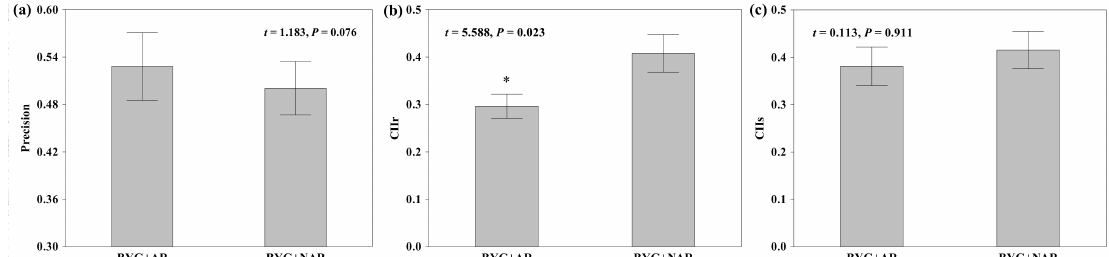
Figure 3. Root foraging precision ( a ), competition intensity index (CII r , b ) and (CII s , c ) of barnyardgrass grown as a mixed culture with allelopathic rice (BYG + AR) and nonallelopathic rice (BYG + NAR). Each value is the mean ± SE. Bars with different letters are significantly different at the p < 0.05 level according to t test.